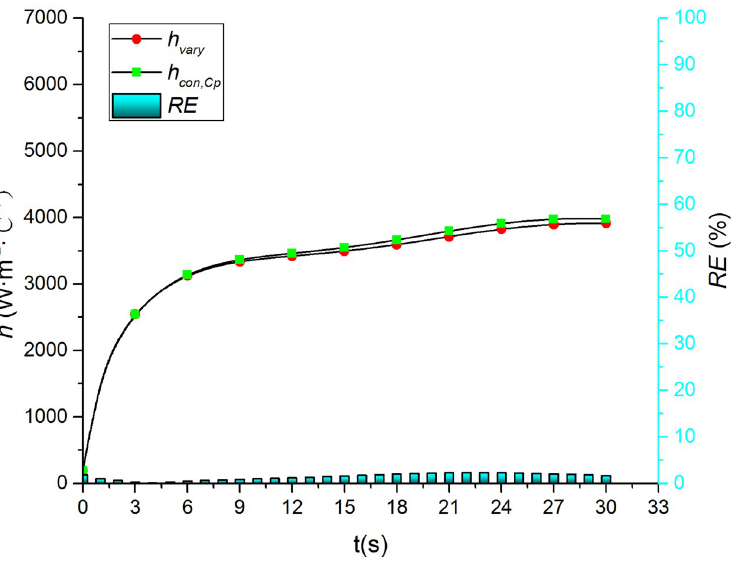
and h var y con ; c p